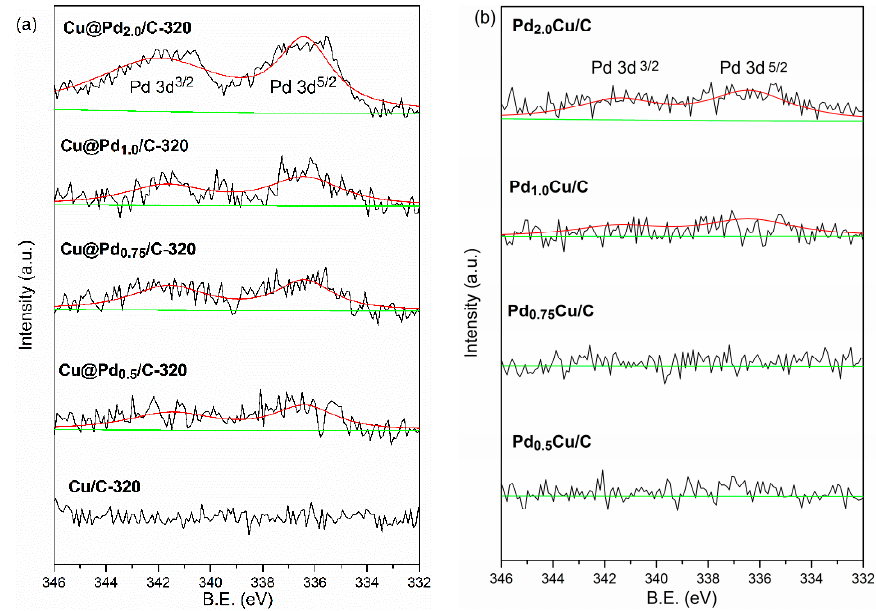
Figure 4. XPS spectra of Cu@Pd/C-320: Cu/C-320 ( a ), and PdCu/C ( b ).